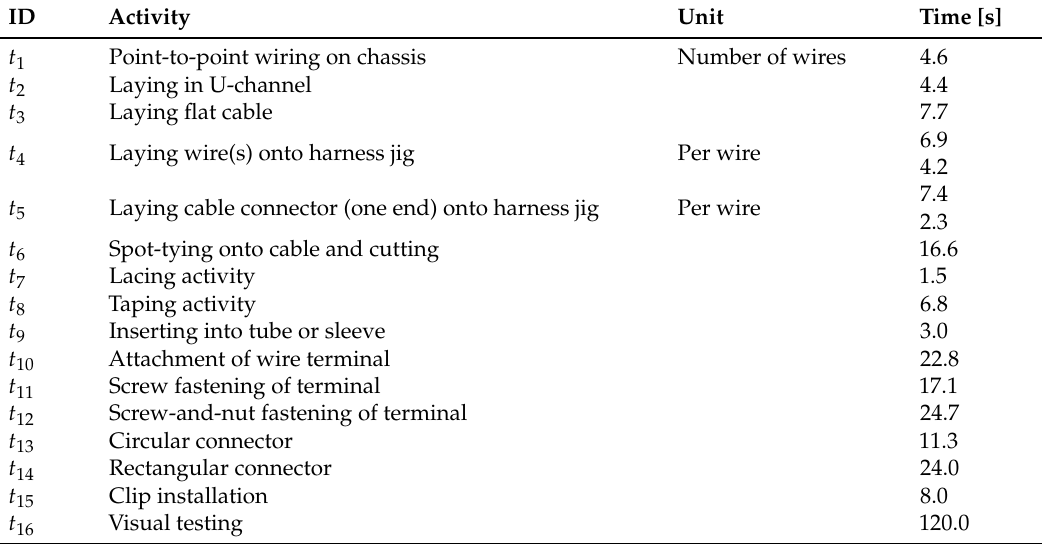
Table 2. Types of activities and the related activity times according to [15]. The activity times are calculated using a direct proportionality approach, e.g., when an operator is laying four wires over one foot, proportionally to the parameter t 4 , the activity time will be 1 × 6.9 s + 4 × 4.2 s = 23.7